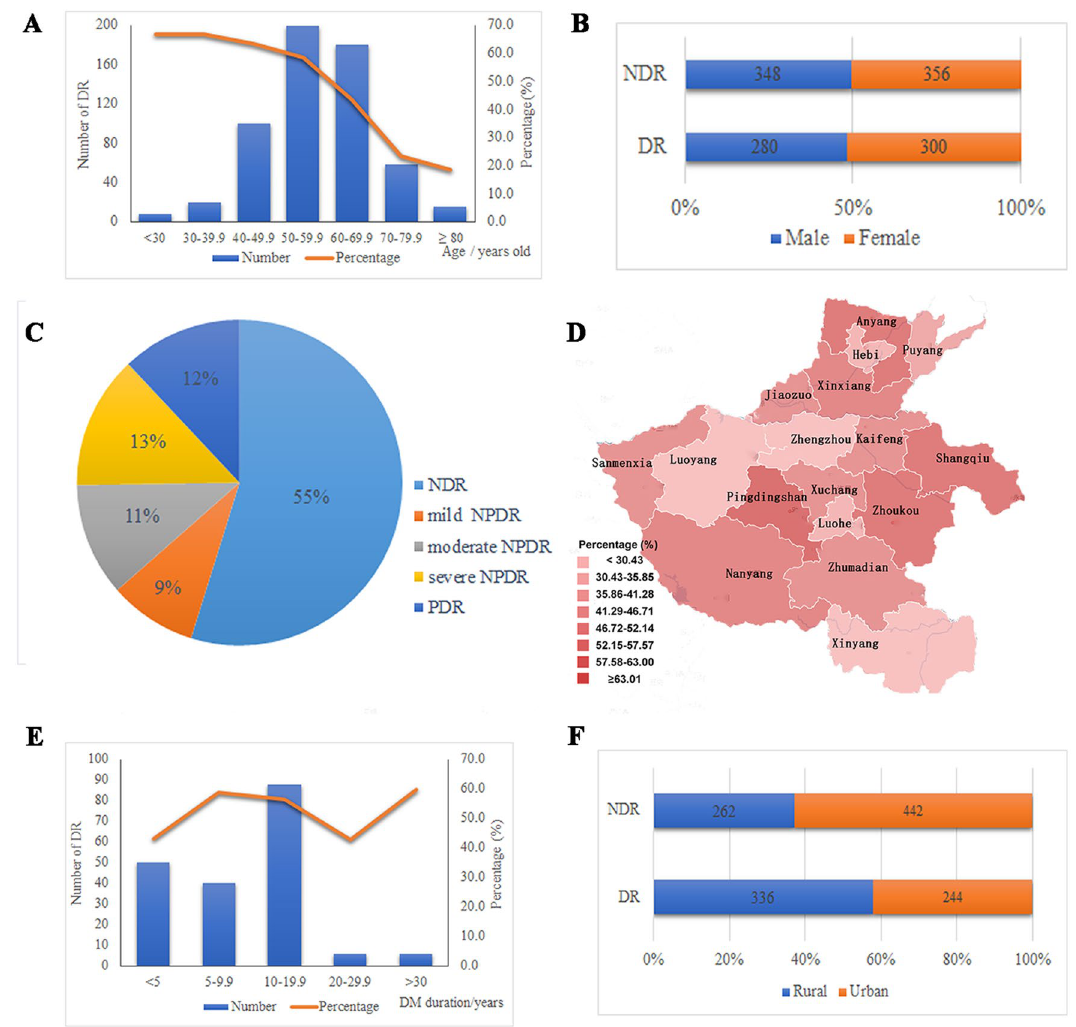
Figure 1. Distribution characteristics of DR in DM patients. ( A ) Age distribution of DR in DM patients; ( B ) Gender distribution of DR in DM patients; ( C ) Distribution of DR according to severity levels; ( D ) Regional distribution of DR in DM patients; ( E ) Relationship between DR and the disease duration of DM; ( F ) Number of DR cases in rural and urban